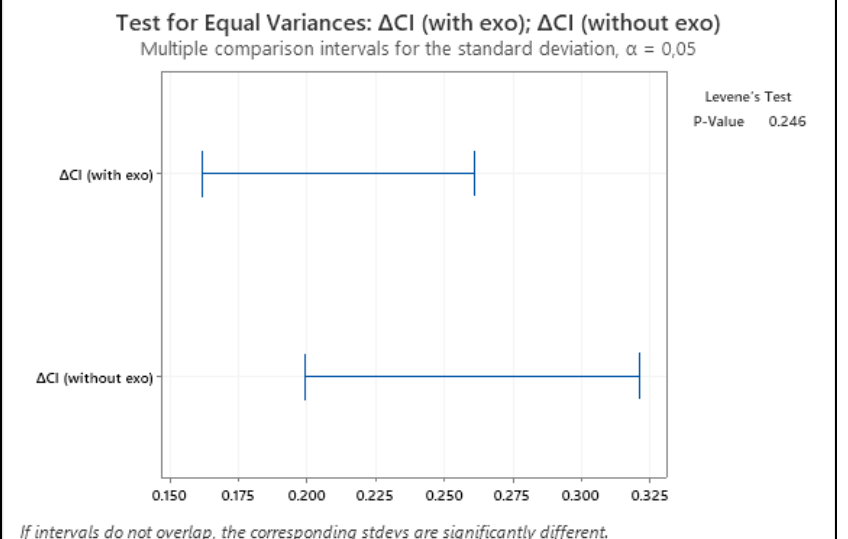
Figure 6. Test for equal variances of the samples ∆𝐶𝐼 𝑤𝑖𝑡ℎ 𝑒𝑥𝑜 and ∆𝐶𝐼 𝑤𝑖𝑡ℎ𝑜𝑢𝑡 𝑒𝑥𝑜 ( p = 0.246). Fraunho- fer